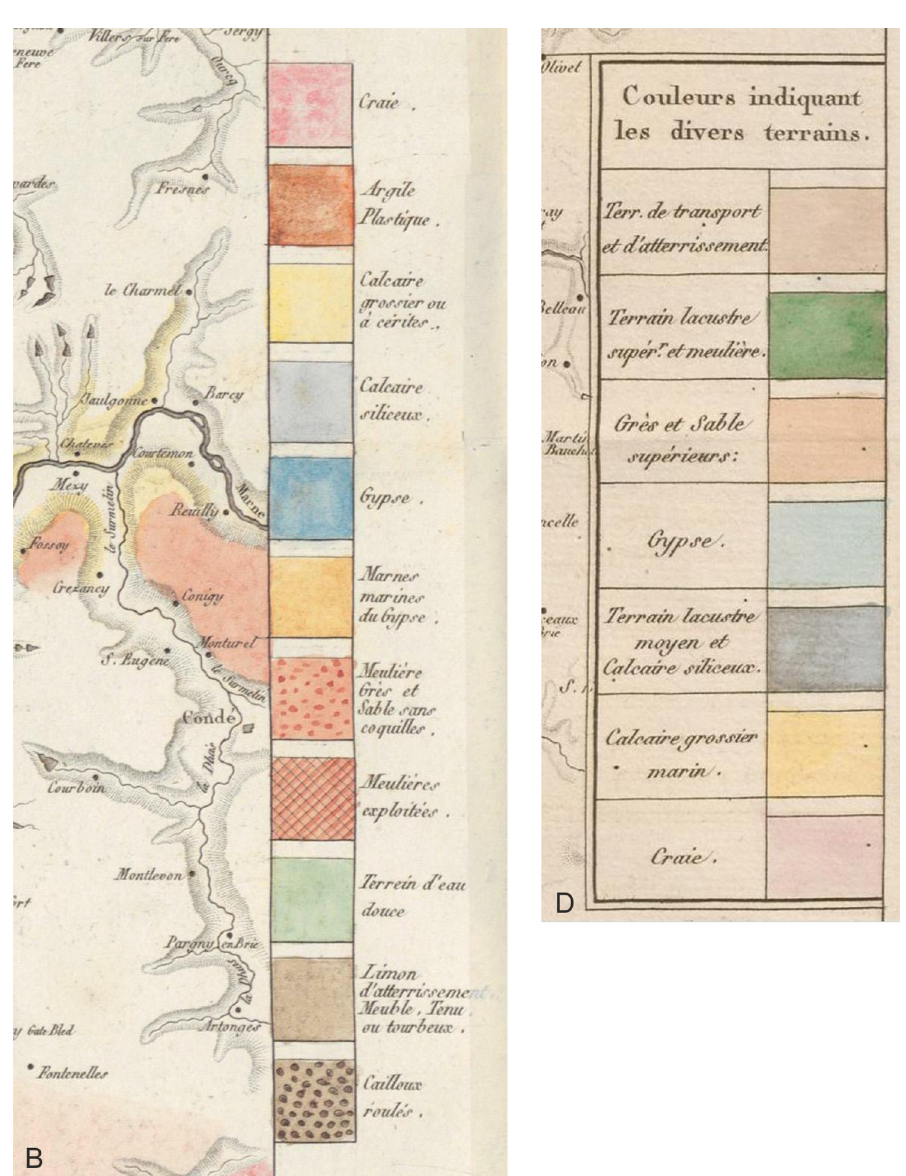
Fig. 4. Comparison of two maps: Carte géognostique des environs de Paris (G. Cuvier and A. Brongniart) published in 1811: a part − A and the explanation including 11 categories − B and Carte géognostique des environs de Paris (G. Cuvier and A. Brongniart) published in 1822: a part − C and the legend including 7 categories − D (from the collection of ETH